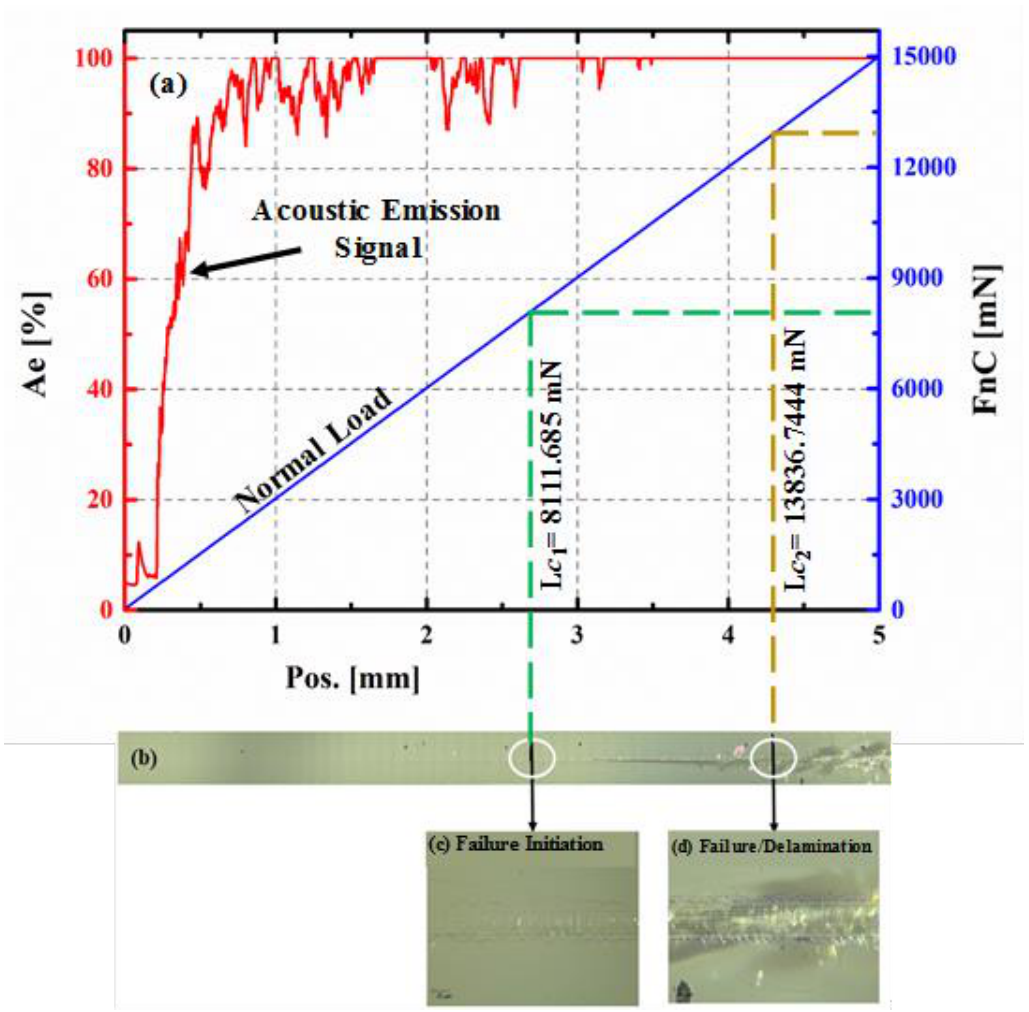
Figure 8. ( a ) A plot showing applied ramping normal load and the acoustic signal generated during the scratch test; ( b ) panoramic view of the scratch; ( c ) zoomed-in view of the scratch at a location of Lc 1 (failure / crack initiation); ( d ) zoomed-in view of the scratch at location Lc 2 (failure / delamination); for the coating deposited at room